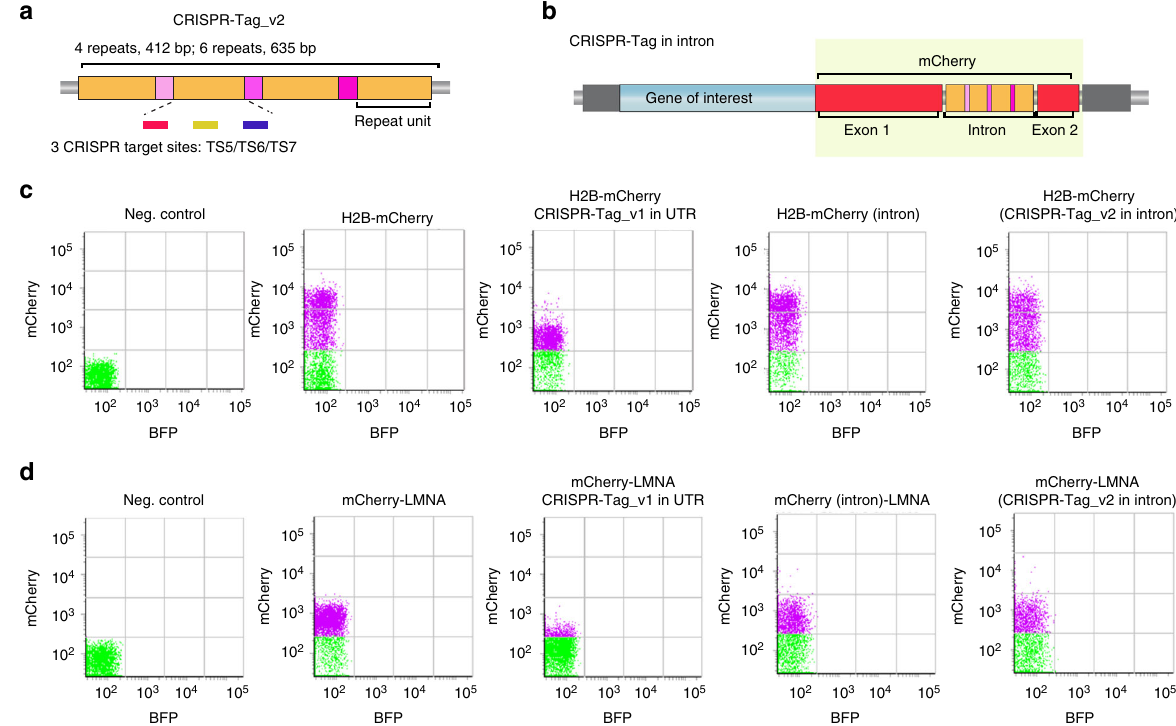
Fig. 2 The protein expression remains normal when hiding CRISPR-Tag in intron. a Schematic of CRISPR-Tag_v2 design which contains four repeats. Each repeat harbors three CRISPR-targeting sites including TS5, TS6, and TS7. b Schematic of CRISPR-Tag positioning in the intron of mCherry. The fragment including mCherry and CRISPR-Tag, indicated by yellow, was integrated to the N-terminus or C-terminus of a target gene. c , d FACS analysis was performed to characterize H2B-mCherry ( c ) or mCherry-LMNA ( d ) expression in HeLa cells. Each dot represents single cells. BFP serves as an irrelevant channel. The distribution of dots along the y -axis indicates mCherry signal